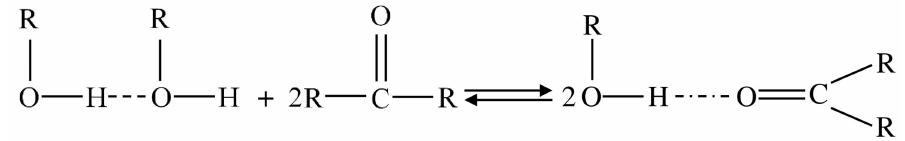
Figure 4. Schematic diagram of the destruction of the self-associated complex of alcohols by ketone. R is the hydrocarbon